Question: Provide a one-line summary of what is displayed.
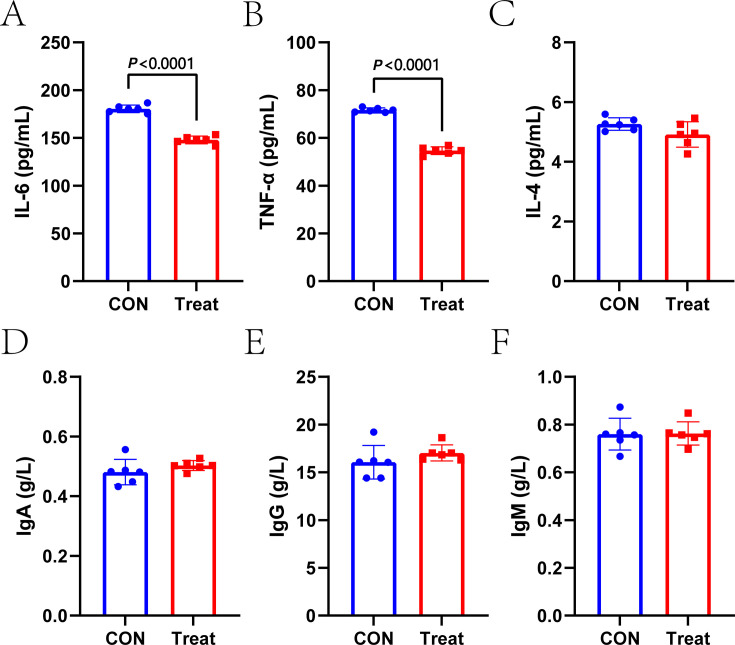
Answer: Effects of supplemental fermented Chinese herbal medicine on serum immune parameters in lambs. Data are presented as mean ± SEM. Group comparisons were analyzed using an independent samples t -test. Bar graphs showing fermented Chinese herbal medicine effects on lamb serum immune parameters. ( A ) IL-6; ( B ) TNF-α; ( C ) IL-4; ( D ) IgA; ( E ) IgG; ( F ) IgM. Treatment significantly reduced inflammatory cytokines IL-6 and TNF-α, while IL-4 and immunoglobulins IgA, IgG, and IgM remained unchanged.